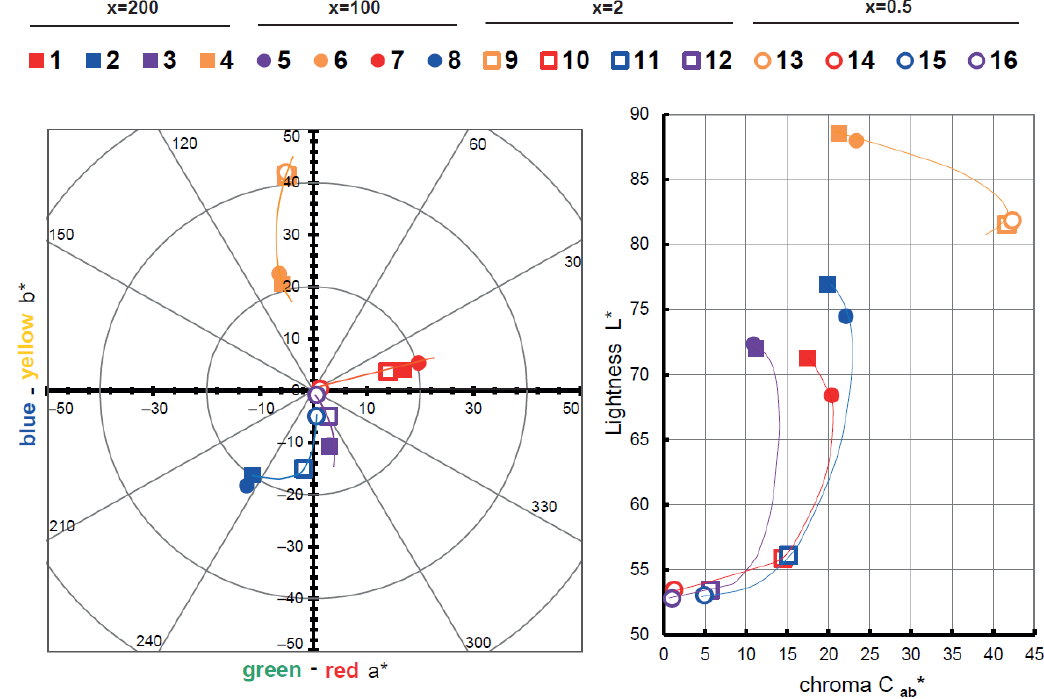
Figure 2. Graphic CIELAB plots for hybrid pigments synthetized under 1–18 conditions using the D65 illuminant and the CIE ‐ 1931 XYZ standard observer. Left, CIE ‐ a * b * color diagram; right, CIE ‐ Cab * L * color chart. color